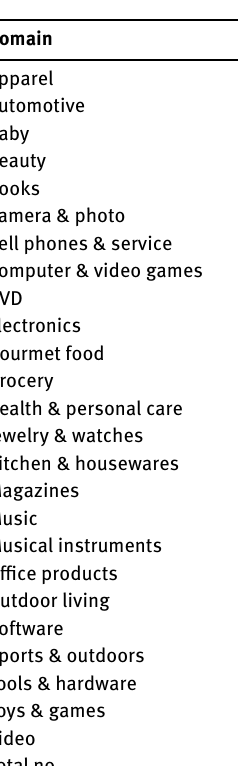
Table 3: Amazon Product Dataset